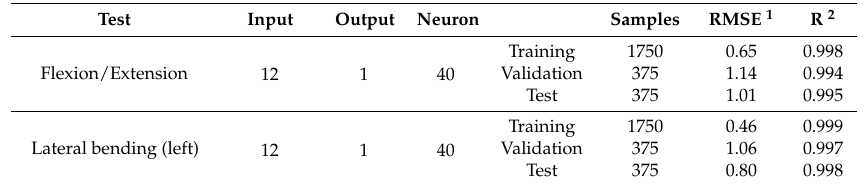
Table 2. The outcome of network training for planar